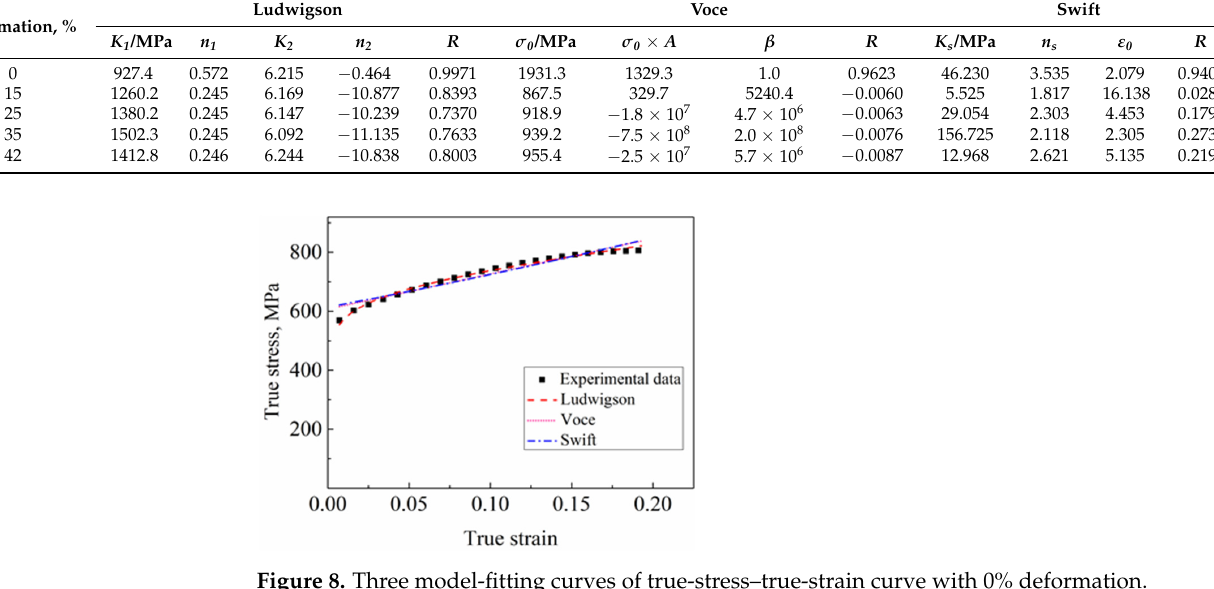
Table 2. Ludwigson, Voce, and Swift regression results of Gr.4 strip for different deformations. Deformation, %